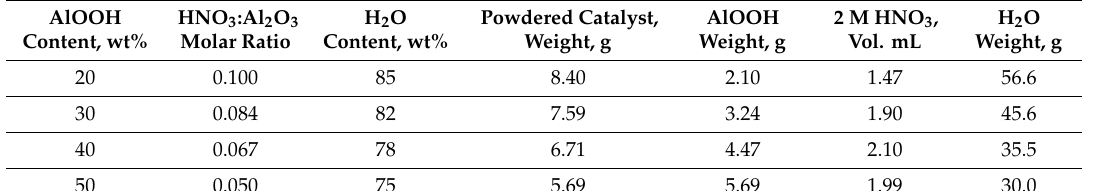
Table 1. Conditions used for preparation of the spherical CuFeAl composite catalysts. The data for obtaining 10 g of spherical catalyst.